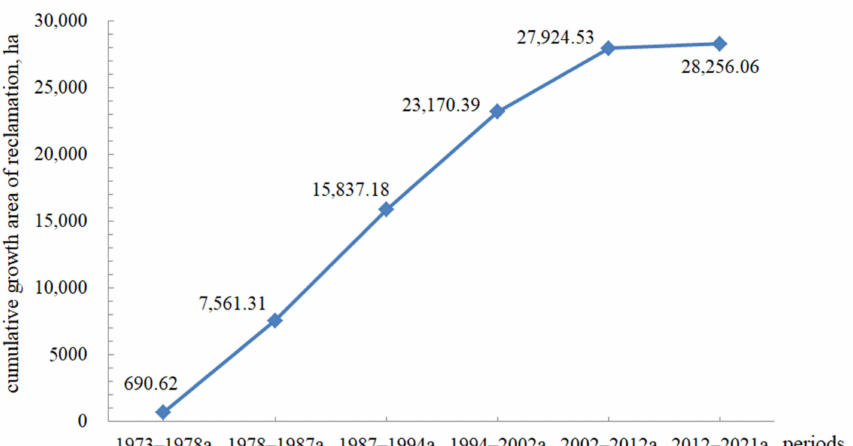
Figure 4. Growth of reclamation areas in Pearl River